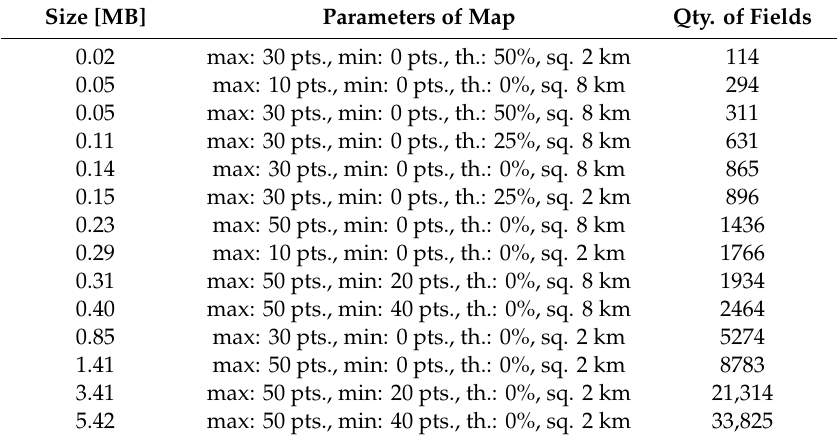
Table 10. Amount of memory occupied by generated